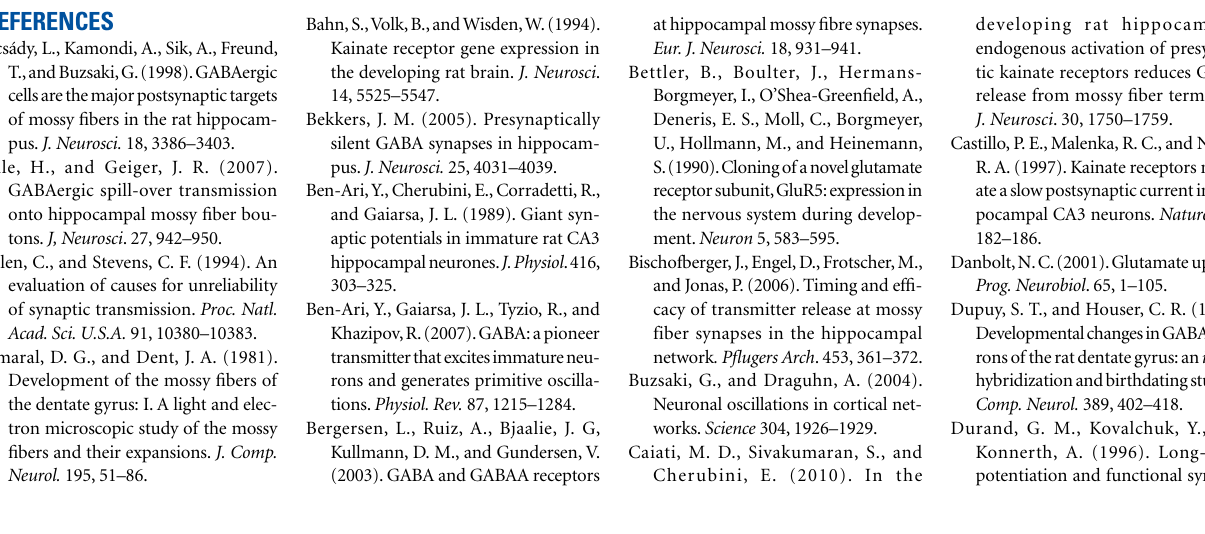
that reproduced the experimental properties of CA3 cells showing fi ring adaptation (see Figure 9E in Hemond et al., 2008), adjusted to take into account the lower spike threshold ( − 45 mV) observed in early development in these neurons (Sivakumaran et al., 2009). The model fi les are available for download from the ModelDB section of the Senselab database (http://senselab.med.